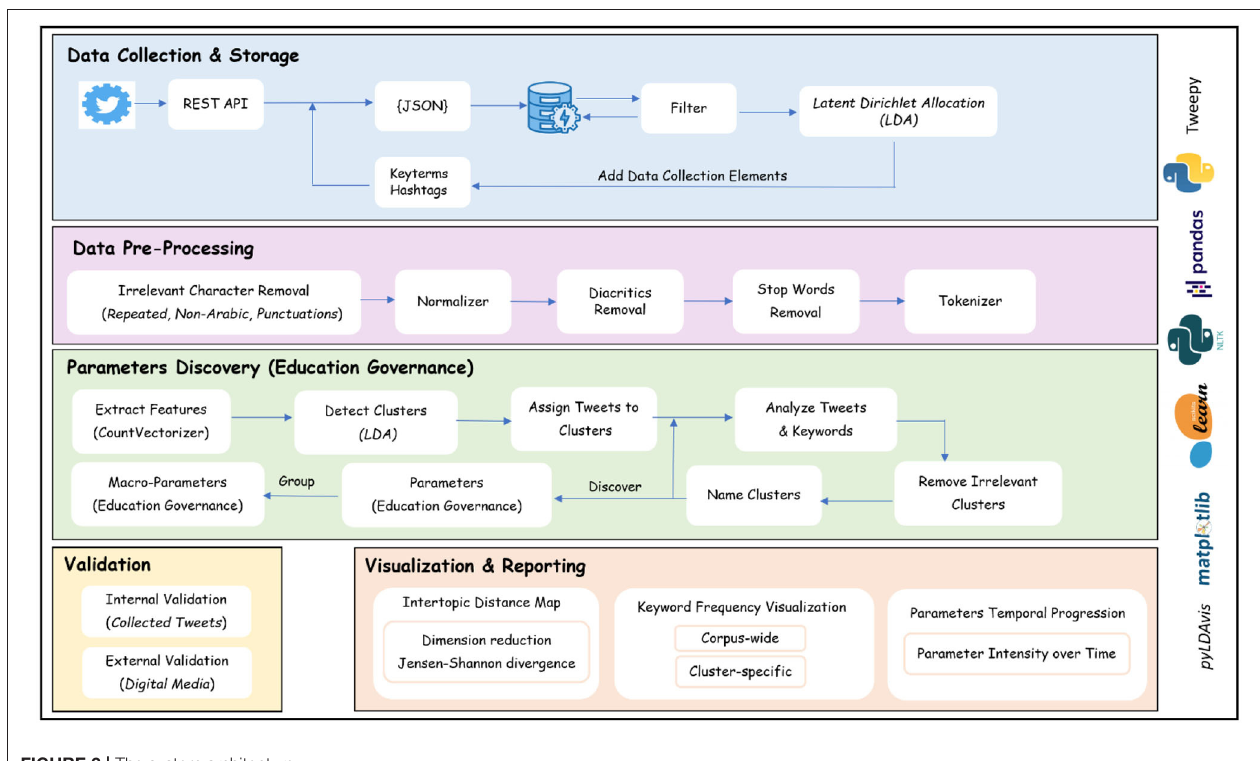
FIGURE 2 | The system architecture.